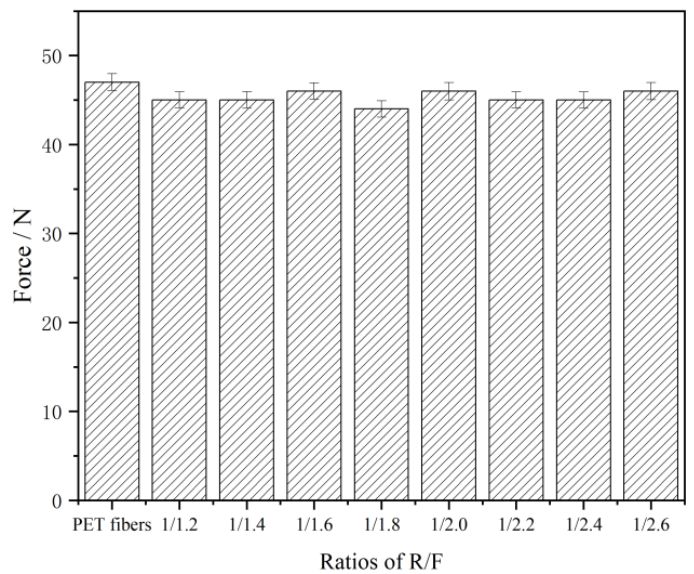
Figure 8. The breaking strength of PET fiber.